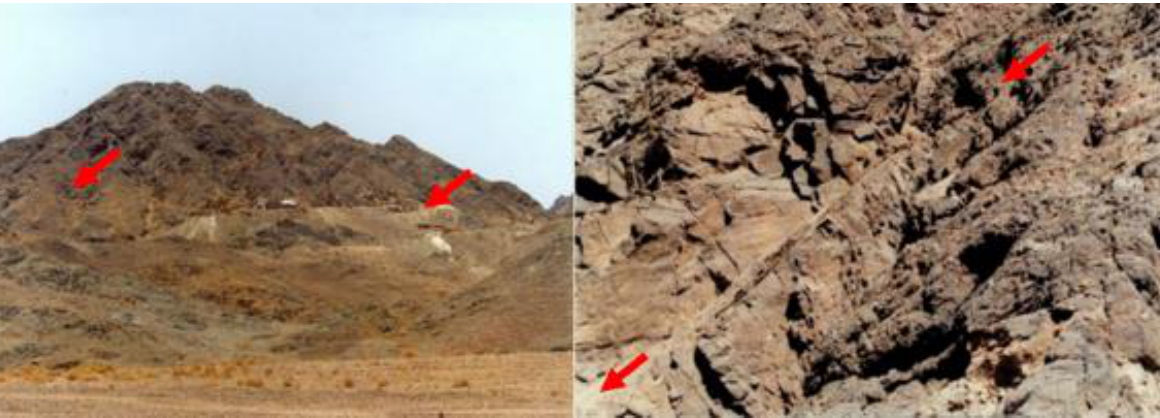
Figure 2. Field pictures from the Sukari gold mine and signed arrows show the location of some collected samples (younger granite).